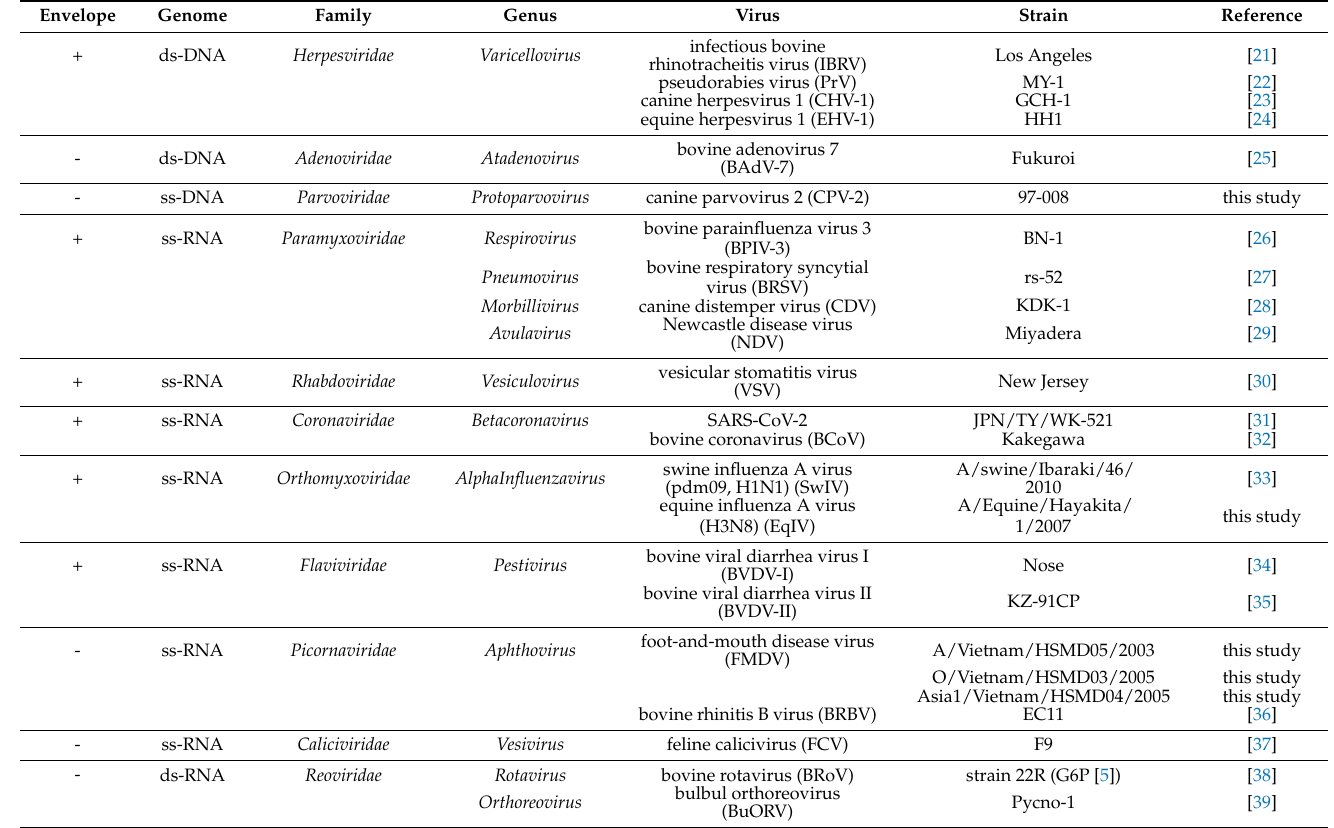
Table 1. Virus strains used in this